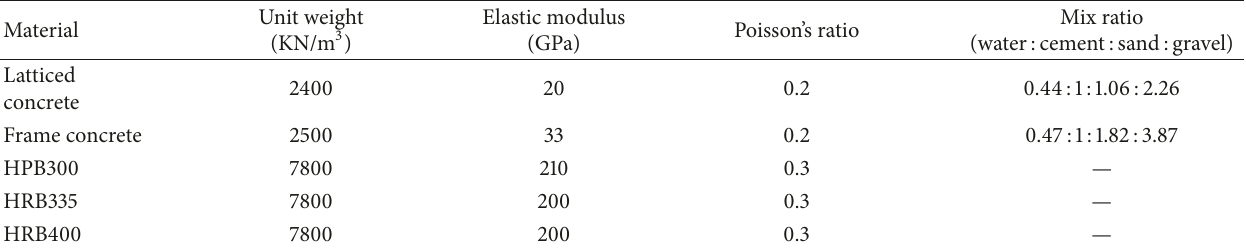
Table 2: Physical parameters of test